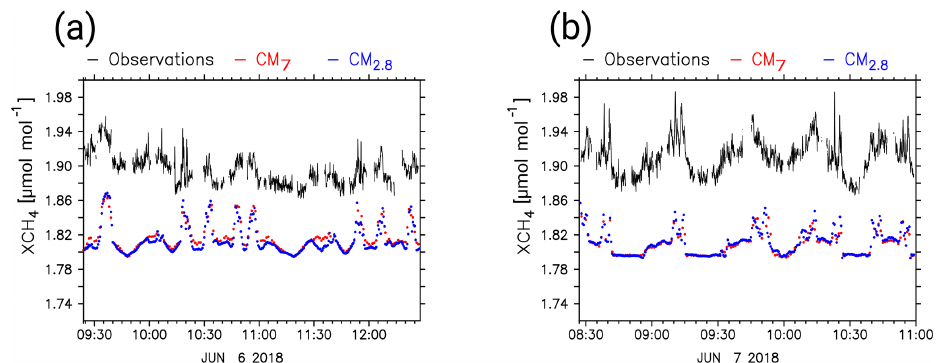
Figure 7. Results of the CHARM-F measurements and the S4D submodel sampling, which was vertically integrated to yield X fl CH4. XCH 4 values of C1 (a) and C2 (b) are displayed in black, and the simulated X fl CH 4 values of CM7 and CM2.8 are shown as red and blue dots, respectively. Mixing ratios are shown in micromoles per mole (µmolmol − 1 ). The time axes display the time of the specific flight in UTC.